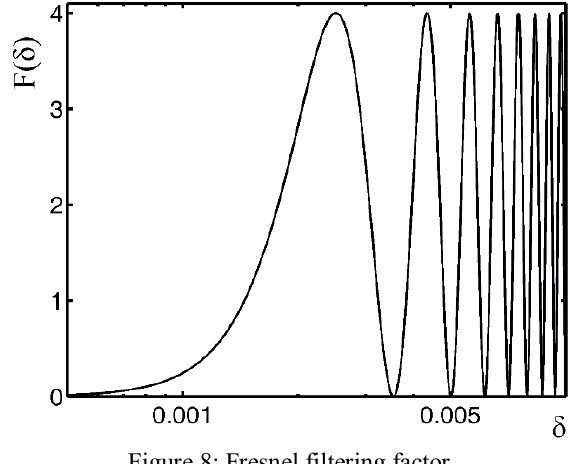
Figure 8: Fresnel filtering